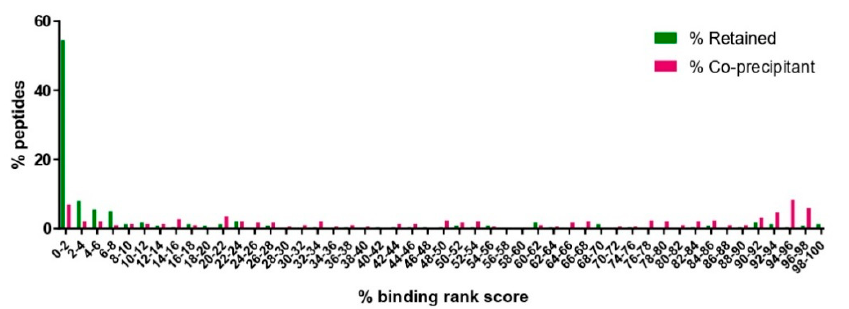
Figure 4. The distribution of predicted percent rank binding scores for peptides considered to be co- precipitants and peptides retained in the combined BoLA-I dataset after removal of the coprecipitating peptides. Peptides with a predicted percent rank binding score of <2% are considered to be binders. A small number of short peptides (<8 amino acids long, n = 8) that did not receive a predicted percent rank binding score were ascribed a default value of 100%.